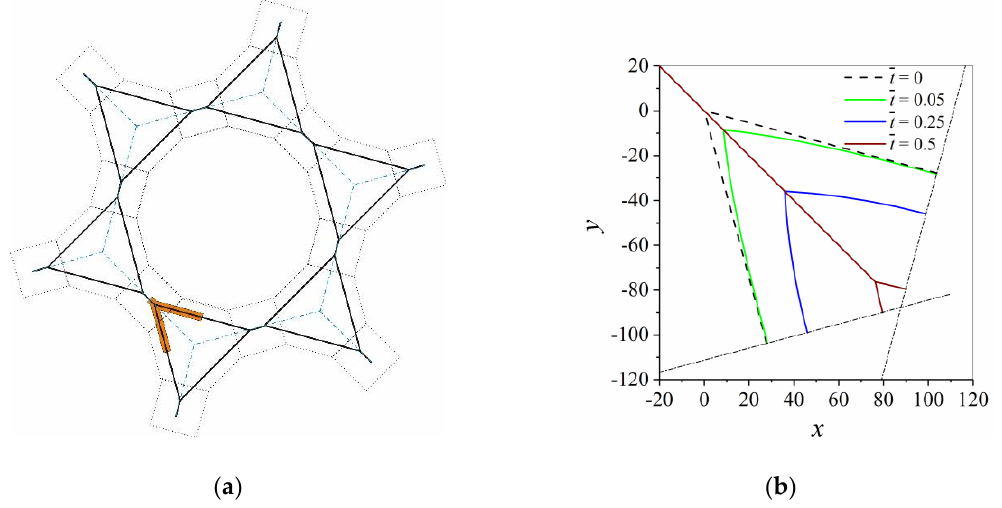
Figure 18. ( a) Evolution of the grain boundary arrangement B. Earlier grain boundaries are represented by dotted lines, and the grain boundaries of the later dodecagon triangle grain boundary network are depicted as continuous lines. The “unit-cell” of the dodecagon-triangle network is highlighted. ( b ) Unit-cell of the dodecagon-triangle network and the shrinkage of the triangles with time.